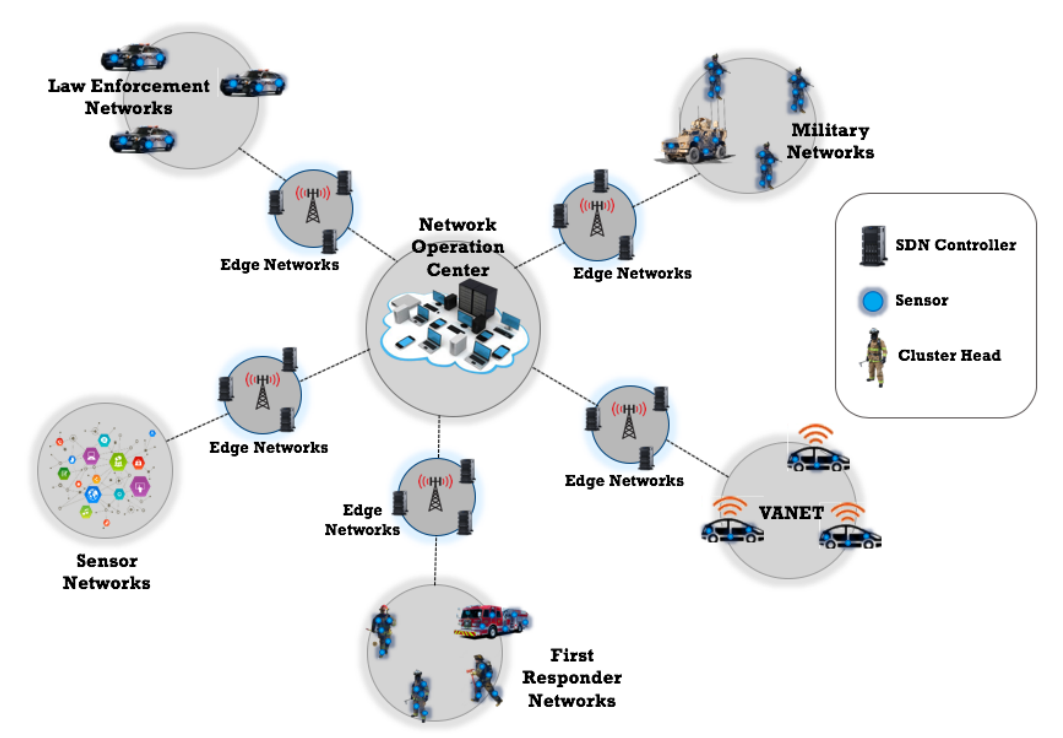
Figure 20. Heterogeneous Multi-domain Networks with the Internet of Things